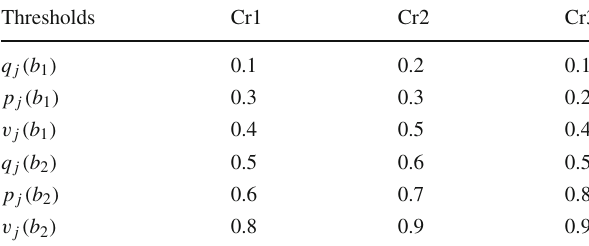
Table 5 Initial values of indifference, preference and veto